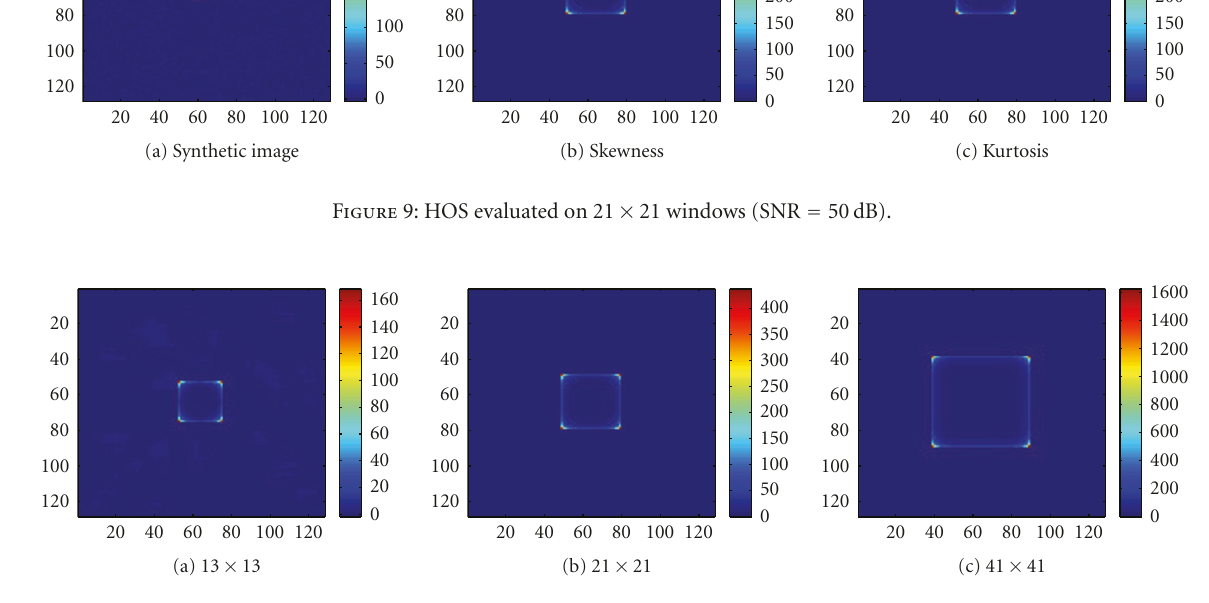
Figure 10: Kurtosis images obtained with di ff erent sizes of window (SNR =